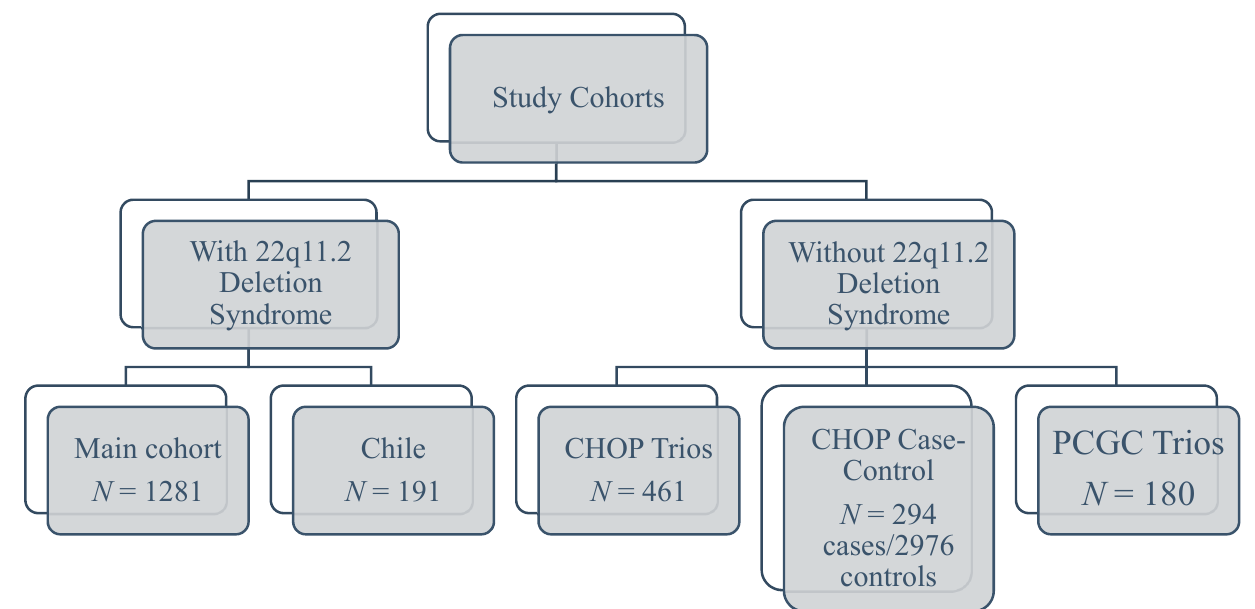
Figure 1. Summary of congenital heart defects cohorts. CHOP, The Children’s Hospital of Philadelphia; PCGC, The Pediatric Cardiac Genomics Consortium.